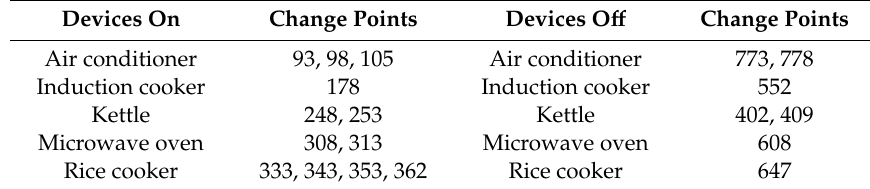
Table 3. Load event change point obtained by the original CUSUM method.